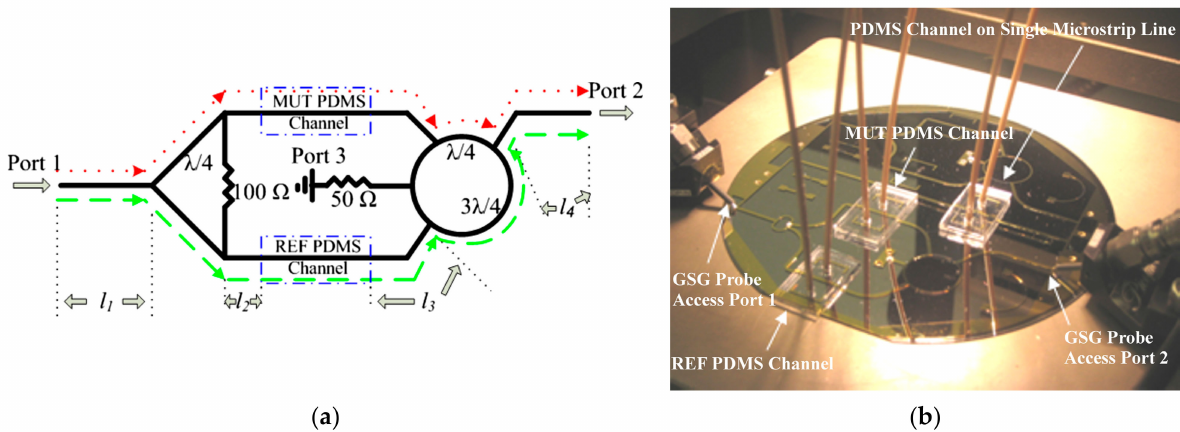
Figure 12. The microwave circuit scheme ( a ) and the photo ( b ) of the device for determining the concentration of the methanol/ethanol in the deionized water [49]. Reprinted from Song, C.; Wang, P.A; radio frequency device for measurement of minute dielectric property changes in microfluidic channels. Appl. Phys. Lett. 2009 , 94 , 1–4, doi:10.1063/1.3072806 with permission from AIP